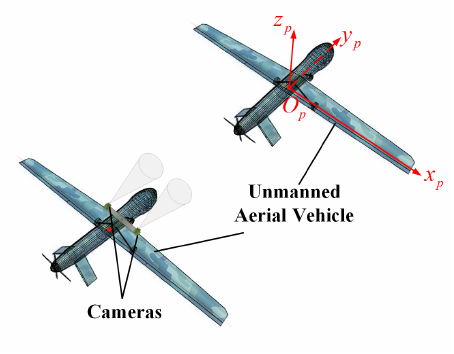
Figure 2. Measuring